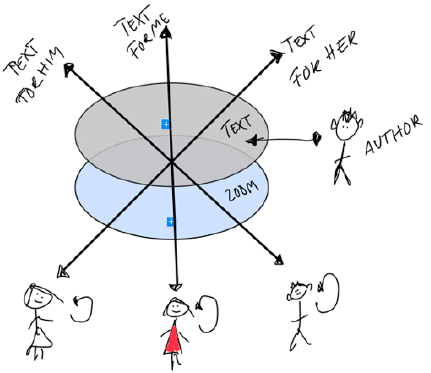
Figure 1. Dialogical relationships in online havruta.